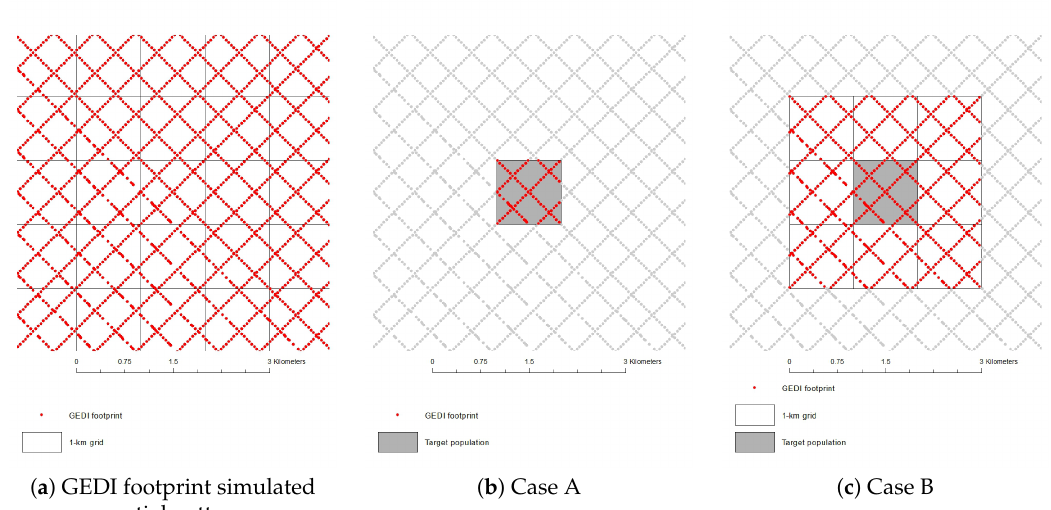
Figure 3. ( a ) Simulated spatial pattern of GEDI footprints and the 1-km grid delineation; ( b ) Case A: data for a single 1-km grid-cell were used; ( c ) Case B: data from neighboring grid-cells were used as well, for the GHMB and GTSMB